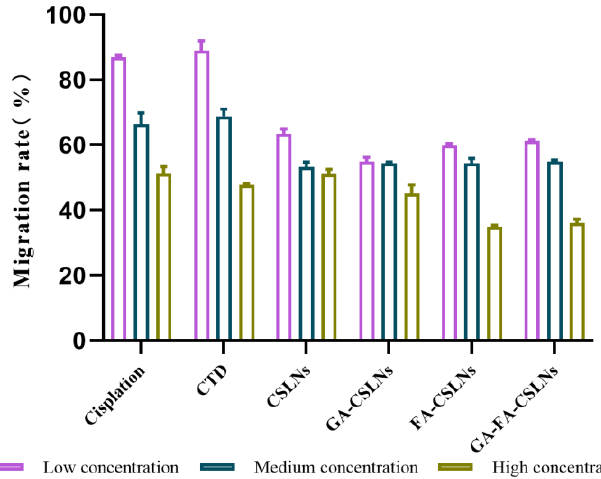
Figure 6. Migration rate of HepG2 cells (mean ± SD, n = 3).